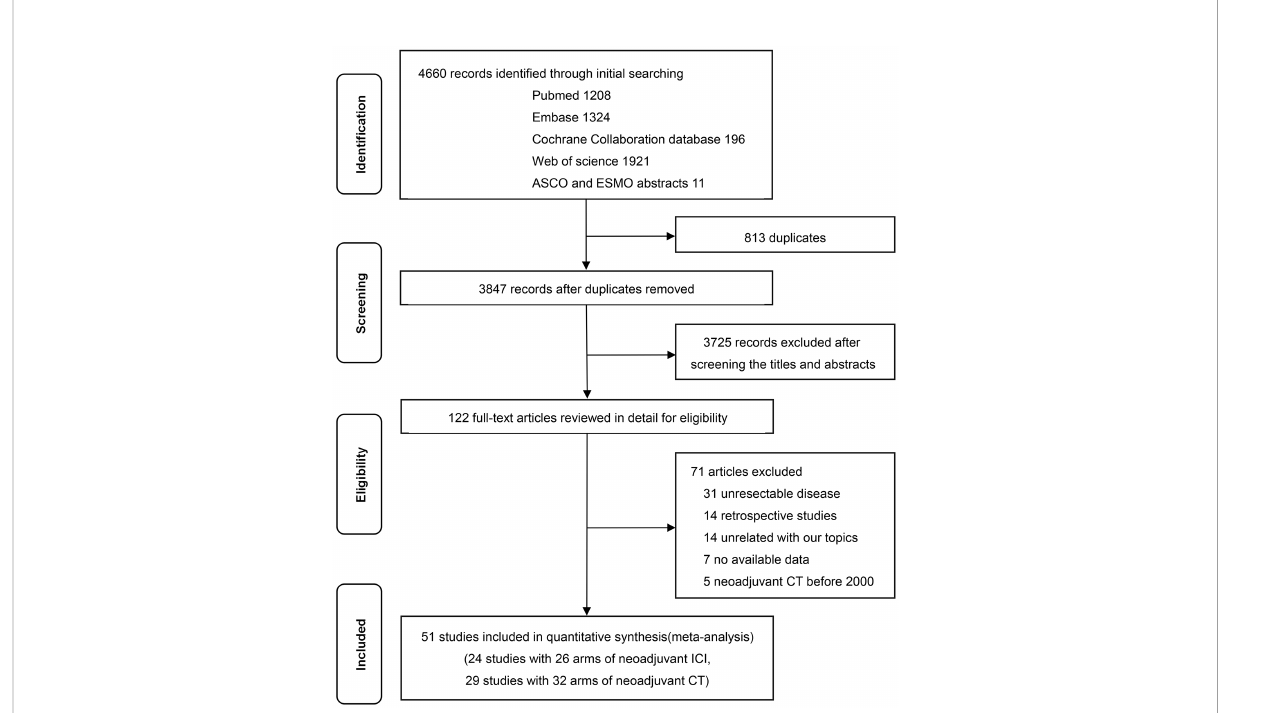
FIGURE 1 Literature search and selection. ICI, checkpoint inhibitor; CT,